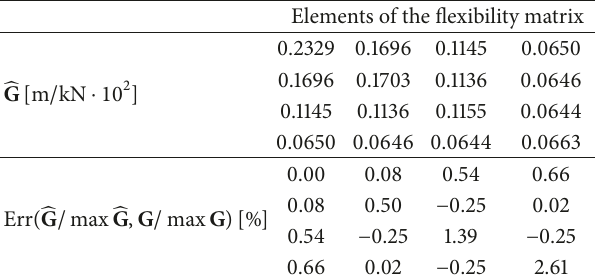
Table 5: Flexibility matrix obtained by using unitary-mass- normalized identified modal vectors (from ERA-based procedure) and relative